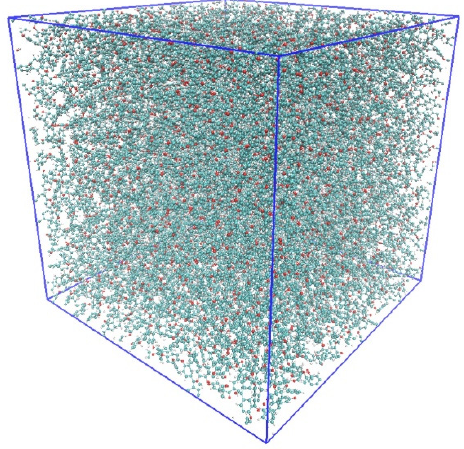
Figure 3. Snapshot of the equilibrium system.